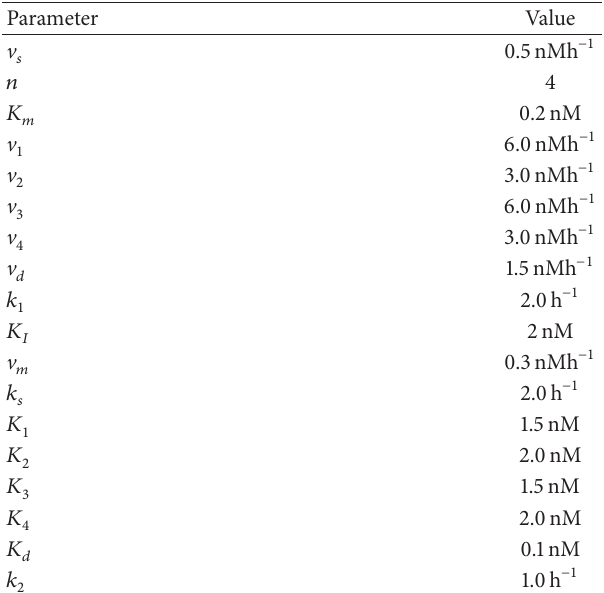
Table 1: Parameter